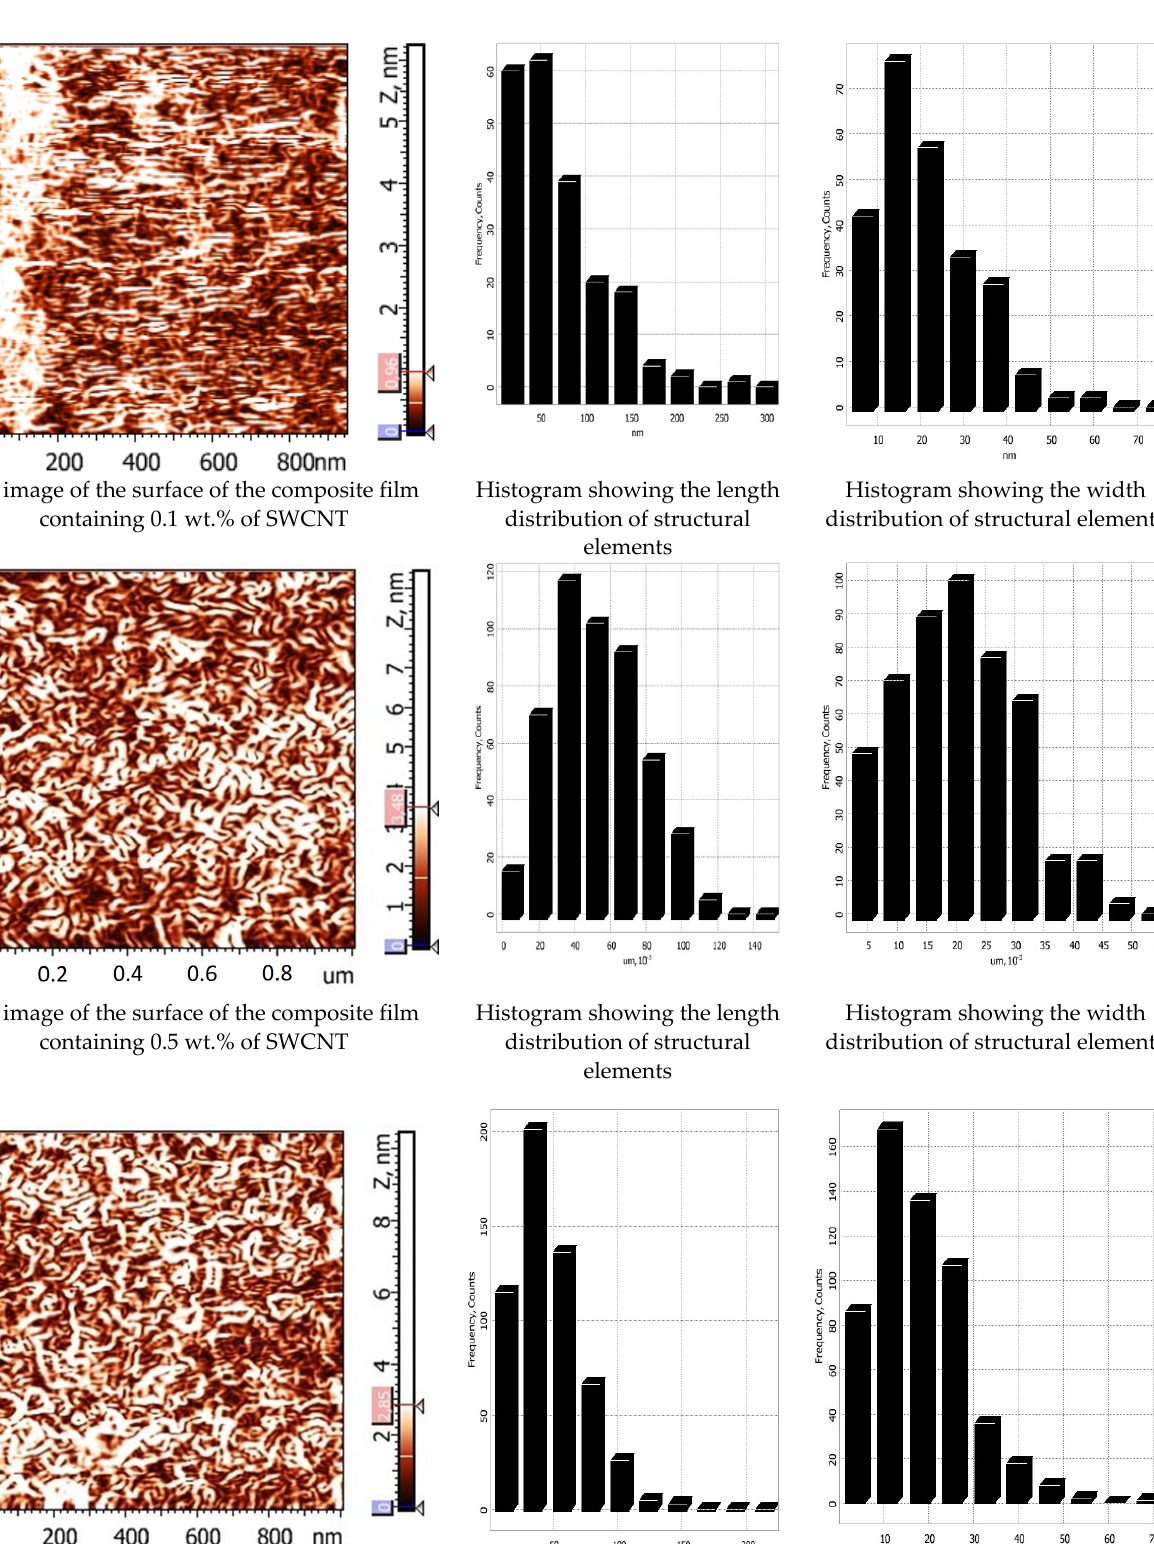
Figure 2. Three-dimensional images of the surface of the chitosan film ( a ) and composite films containing 0.5 ( b ), 1.0 ( c ), 3.0 ( d ) wt.% of SWCNT. Size of the studied surfaces: 1 × 1 µm.